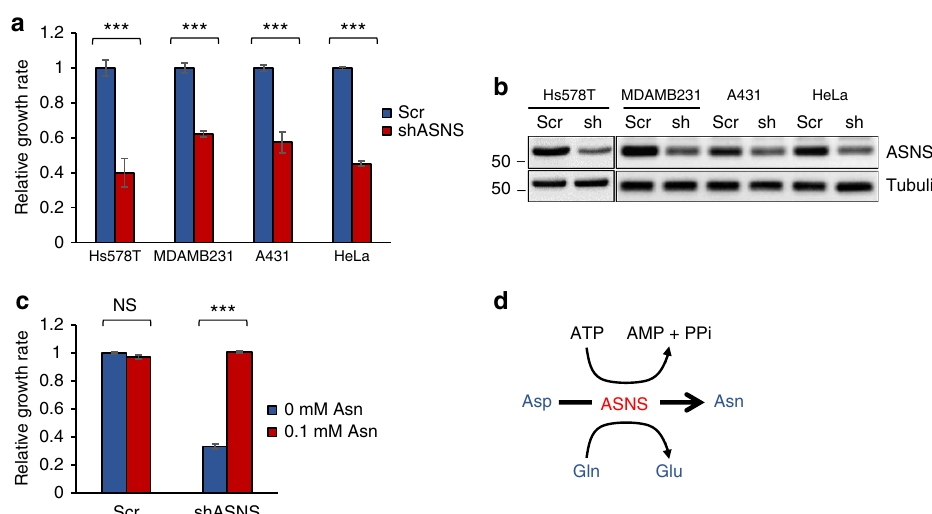
Figure 2 | Asparagine levels regulate cell proliferation. ( a ) Relative growth rates of cancer cell lines stably expressing scrambled shRNA (Scr) or ASNS shRNA. Growth rates are normalized to the scrambled shRNA control for each cell line. ( b ) Immunoblot showing ASNS protein levels on stable expression of scrambled (Scr) or ASNS shRNA in cell lines shown in a . ( c ) Relative growth rates of HeLa cells stably expressing scrambled shRNA (Scr) or ASNS shRNA in the presence or absence of 0.1mM asparagine. ( d ) Reaction catalysed by ASNS. Aspartate (Asp) and glutamine (Gln) are converted to asparagine (Asn) and glutamate (Glu). Error bars denote s.d. of the mean ( n ¼ 3). P values were calculated by the Student’s t -test: *** P o 0.001; NS, not